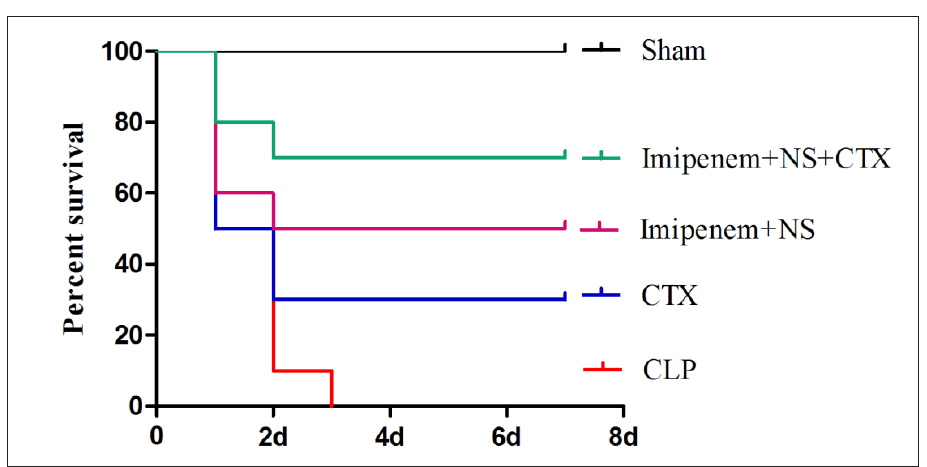
Fig. 1. The survival curve of septic rats (log-rank test P <0.05). The survival values are expressed as mean ± SD, and the significant statistical threshold is P <0.05.